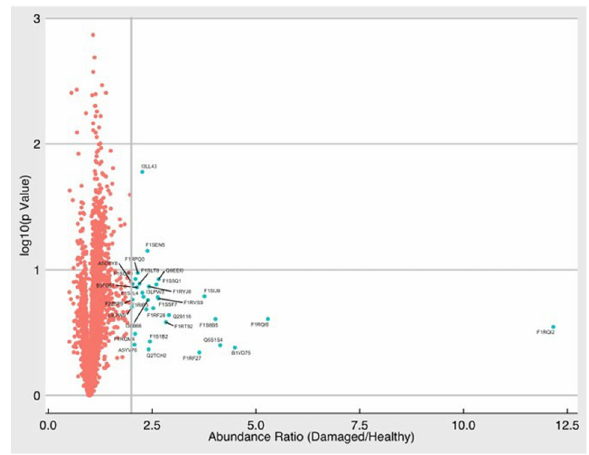
Figure 5. Volcano plot representation of proteomics. Abundance ratios for changes in each protein are shown as log10 of p value of infarcted/health segments within the same hearts (n = 5) (R Software version 3.4.4, R Foundation for Statistical Computing, Vienna, Austria. URL https:// www.R- proje ct. org/).